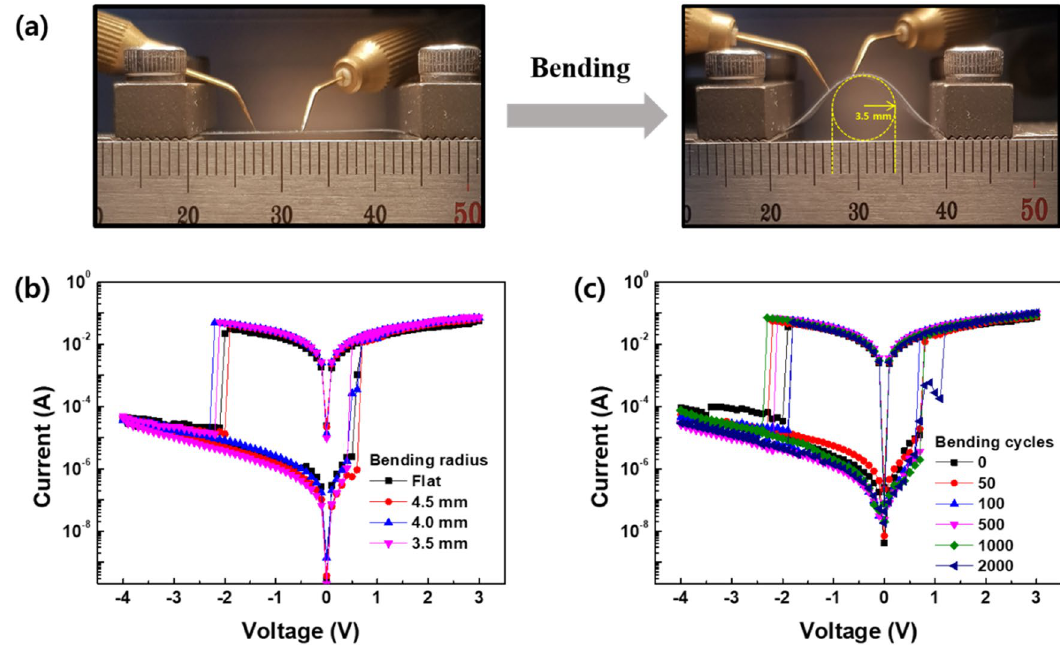
Figure 5. ( a ) Photographs of the zein-based device subjected to bending from the flat state. ( b ) Comparison of I–V curves under mechanical deformation from the flat state to 3.5 mm of bending radius and ( c ) bending cycles up to ~ 2000